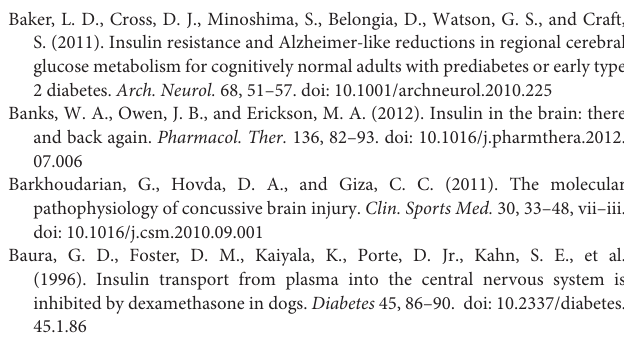
FIGURE S1 | Western immunoblots of subcellular fractions derived from control hippocampal cultures. (A) Top: Representative GAPDH immunoblots of total membrane (total mem.), cytosolic, and plasma membrane (p.m.) subcellular fractions. Bottom: Data were quantified from 2 lanes for the total mem. and cytosolic fractions; due to the low protein yield in the p.m. fraction, only 1 lane was quantified. As expected, GAPDH signal was found in all 3 subcellular fractions. (B) Top: Representative calnexin Western immunoblots of the 3 subcellular fractions. Bottom: Data were quantified from 2 lanes for all fractions. As anticipated, calnexin signal was only detected in membrane-containing fractions, suggesting successful separation of the cytosol. All data represent means or means ± SEM derived from a single experiment ( n = 1). FIGURE S2 | Comparison of Ponceau and Coomassie counterstains for Western immunoblot quantification in the same blot. (A) Photomicrographs of the same membrane stained with Ponceau (before probing) and Coomassie (after probing). Similar uniformity across individual lanes is clearly visible using either stain. (B) Quantification of GLUT3 and GLUT4 target bands following normalization to either Ponceau or Coomassie yielded similar relationships between the 2 conditions tested (left vs. right). Because this experiment was designed to address the impact of total protein normalization using two different techniques, we did not statistically test for differences between GLUT3 and GLUT4 across conditions tested ( n = 1); thus, this does reflect the overall means presented in Figure 3 using an n of 4. All data represent means ± SEM derived from only 2 lanes in this experiment ( n =